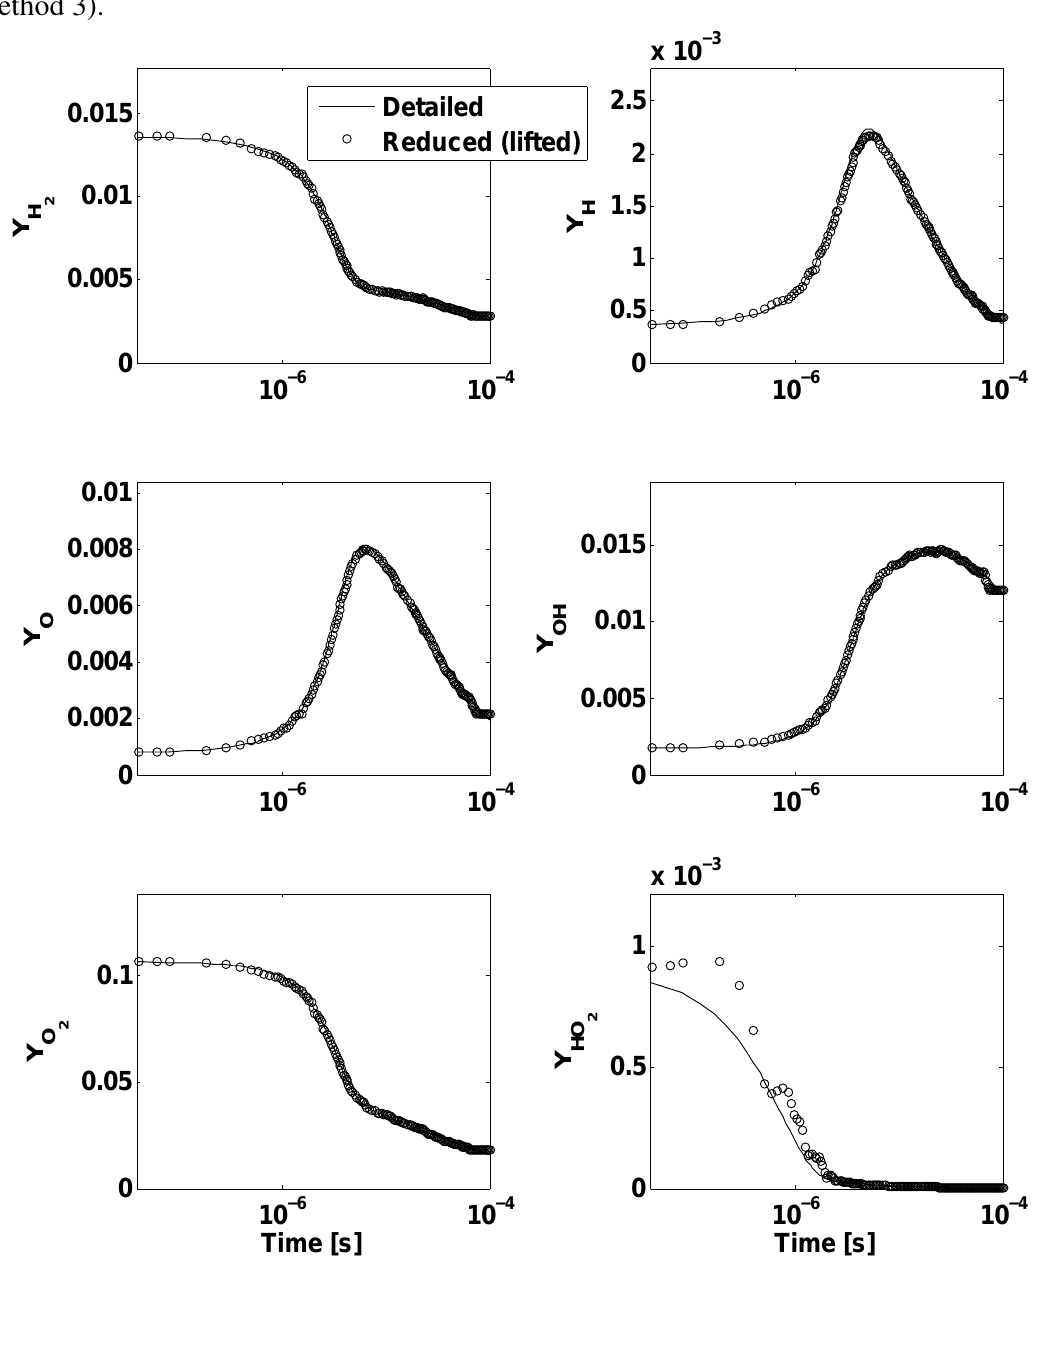
Figure 15. The initial condition in the Diffusion Maps’ space [0 , 0] is first lifted into (cid:60) 9 and then relaxed towards the equilibrium point by the detailed kinetics Equation (8) using the readily available Matlab solver, ode45 (continuous line). Symbols report the corresponding time series as obtained by lifting the reduced solution at the bottom of Figure 13 ( i.e. , method 3). Detailed Reduced